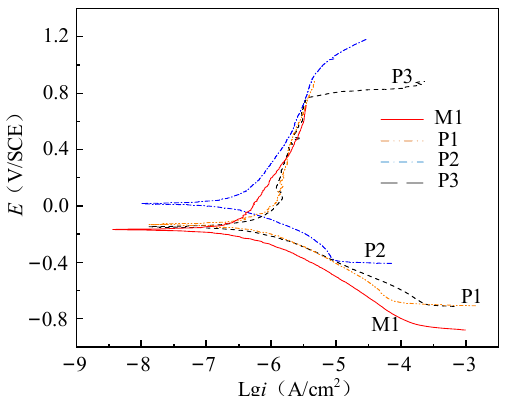
Figure 8. Potentiodynamic polarization curves of milling and electrochemical polishing samples.